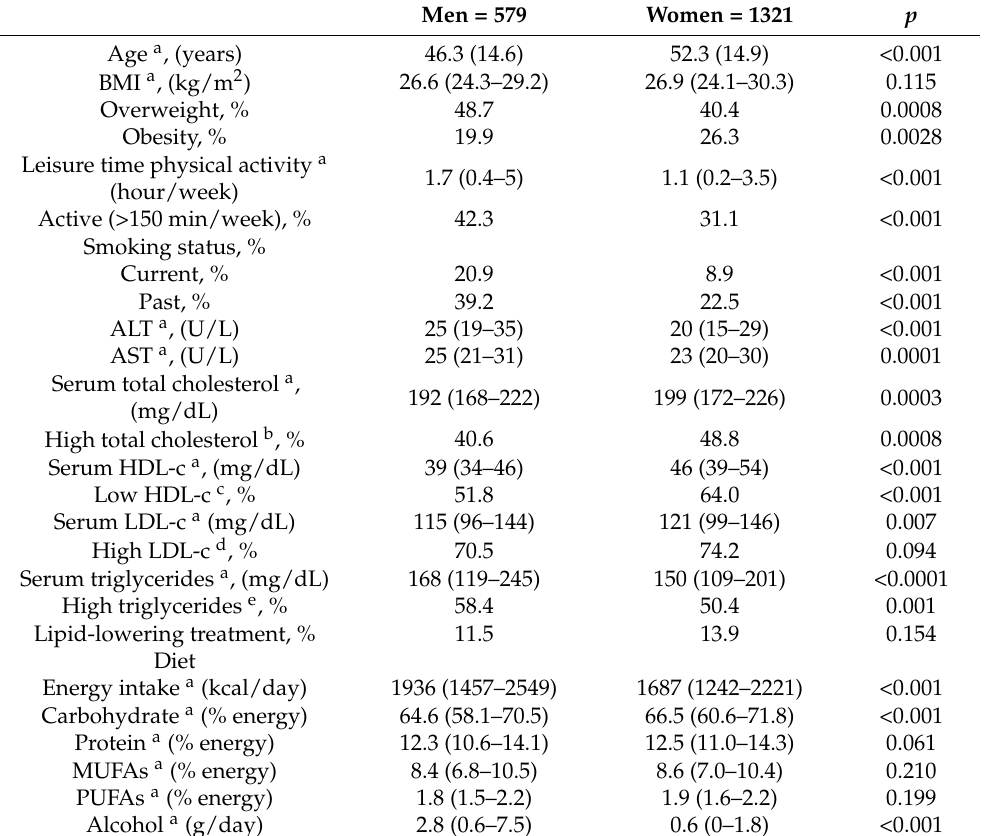
Abbreviations: BMI—Body Mass Index; HDL-c—high-density lipoprotein-cholesterol; LDL-c—low-density lipoprotein-cholesterol; ALT—Alanine aminotransferase; AST—Aspartate aminotransferase;